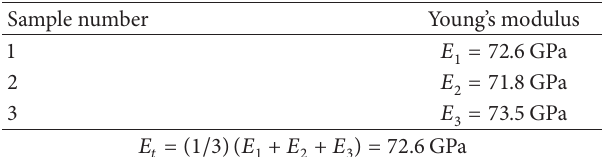
Table 2: Test data